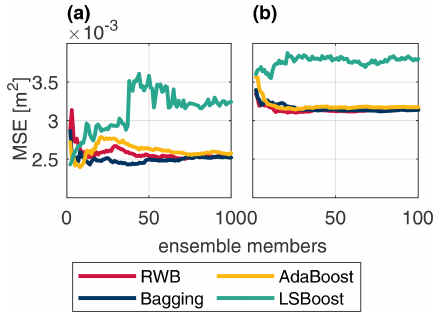
Figure 6. Test MSE across ensemble size for RWB (red), bag- ging (blue), AdaBoost (yellow), and LSBoost (green) for the Don River (a) and Bow River (b) .